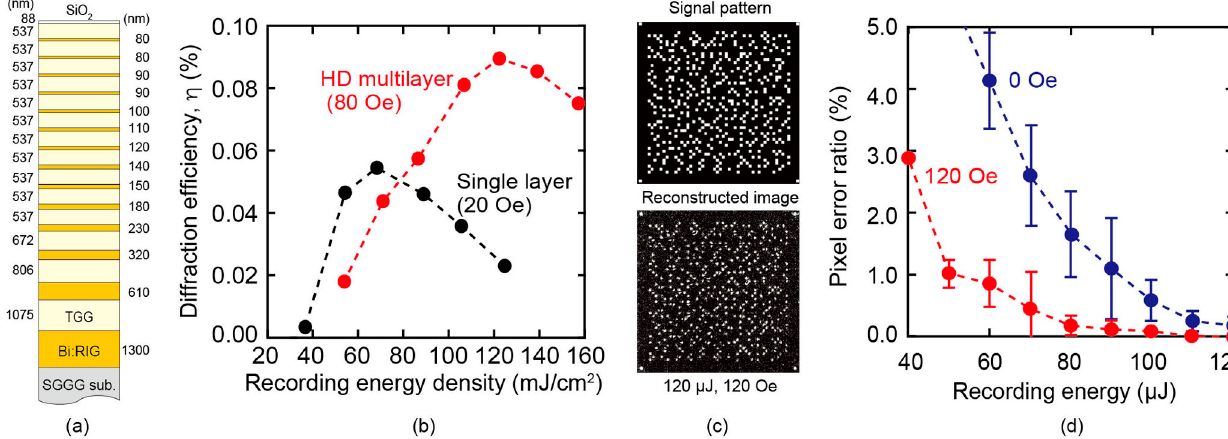
Figure 10. ( a ) Designed structure of HD multilayer medium; ( b ) diffraction efficiency of HD multilayer and single layer media; ( c ) original signal pattern and reconstructed image from HD multilayer medium. The signal pattern consists of 64 × 64 pixels; ( d ) pixel error ratio of the reconstructed signal with and without the assisted magnetic field [33].